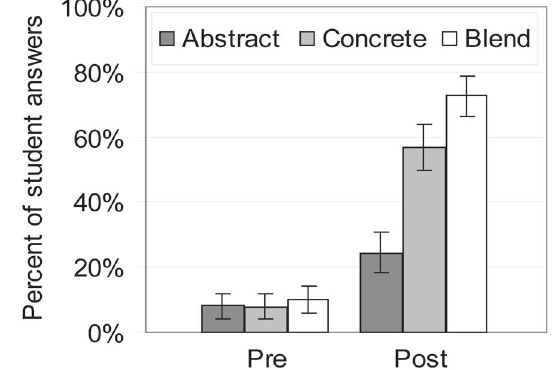
FIG. 6. Fraction of correct answers on pre-post question 1 from the across-domain study. Error bars represent (cid:3) the standard error on